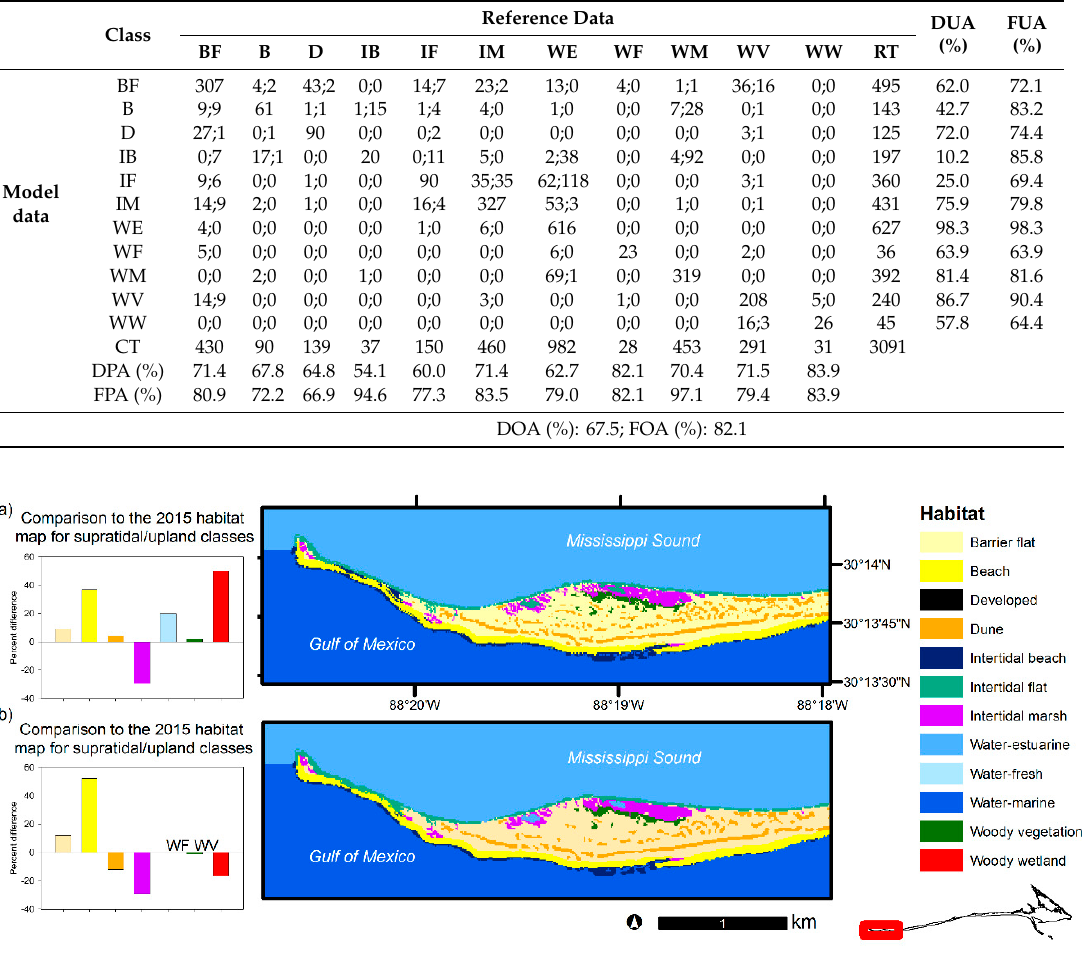
Figure 8. Barrier island habitat contemporary (i.e., 2015) habitat model outputs and percent difference comparison for supratidal / upland habitat compared to the 2015 habitat map Enwright et al. [28], Dauphin Island, Alabama, USA. ( a ) Contemporary model without post-processing. ( b ) Contemporary model with post-processing and four-pixel minimum mapping unit.